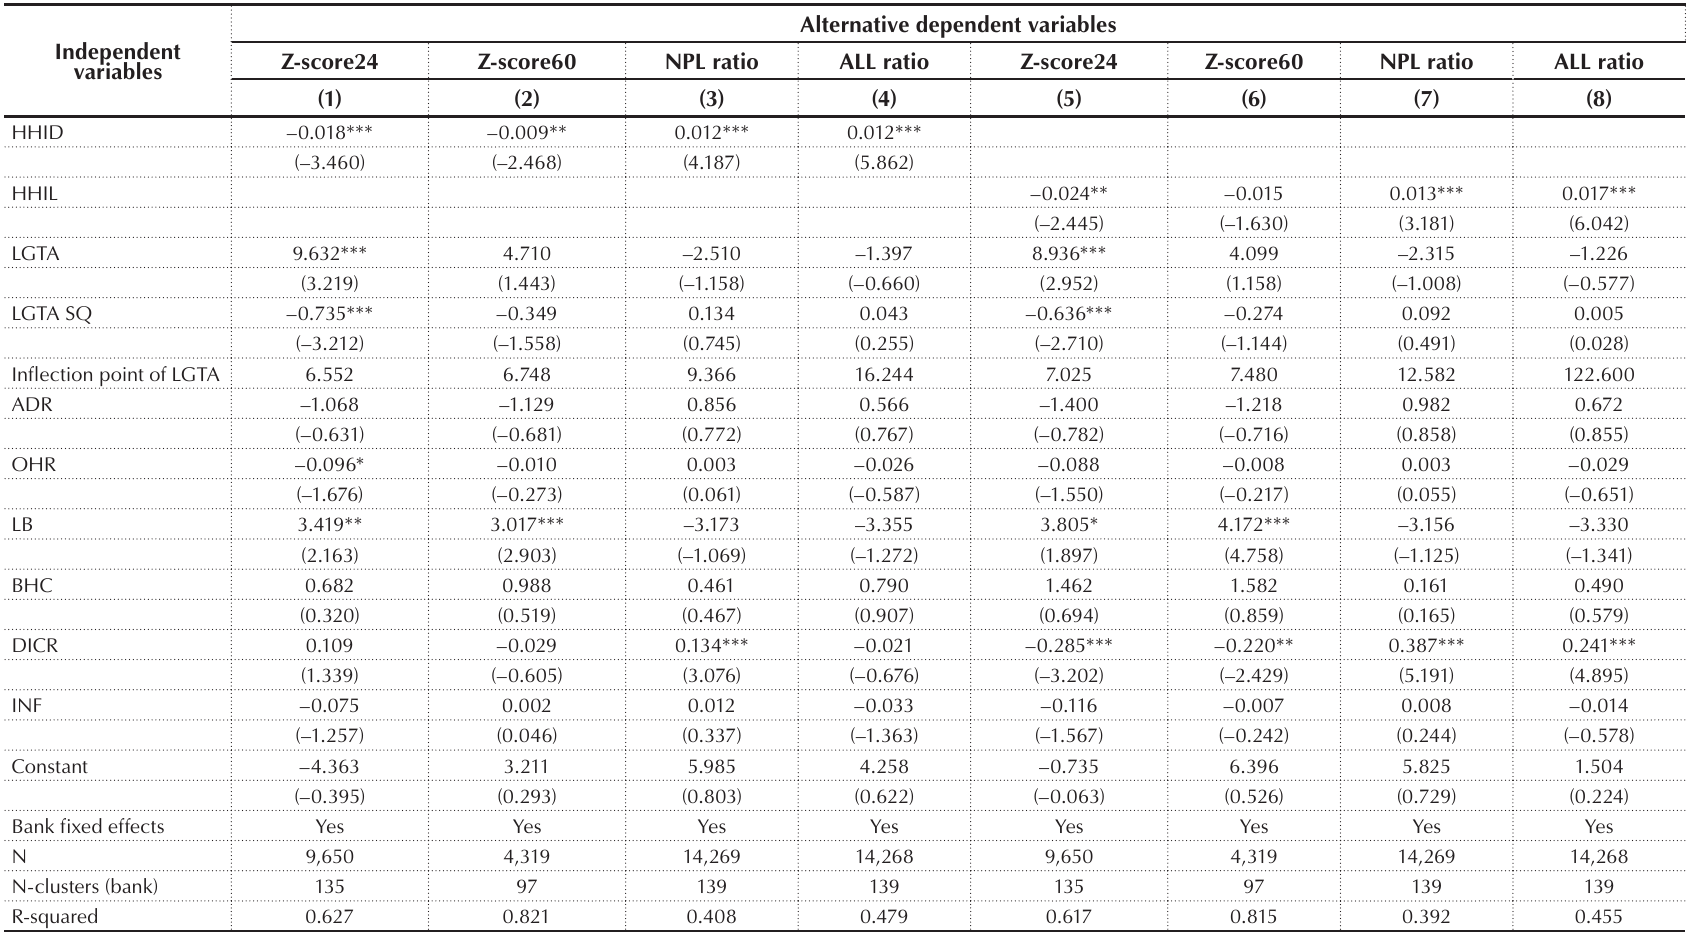
Panel A. Alternative bank fragility